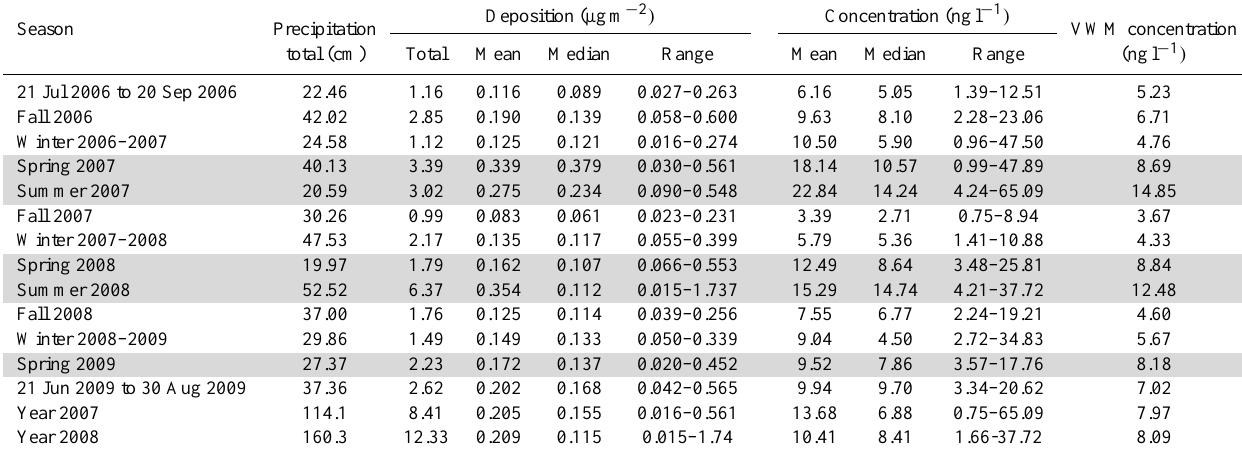
Table 1. Seasonal and annual total precipitation, Hg wet deposition, and concentration summary statistics for Thompson Farm. Spring and summer are shaded for easier visual comparison by